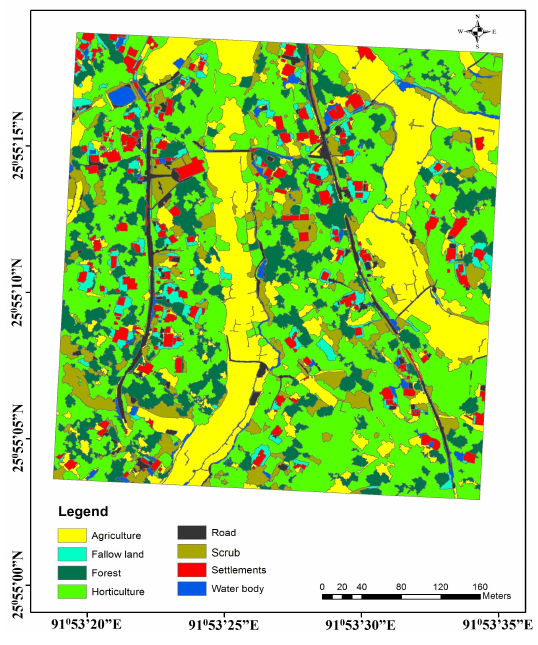
Figure 6. Classified image of land cover classes for part of the village (level-1)